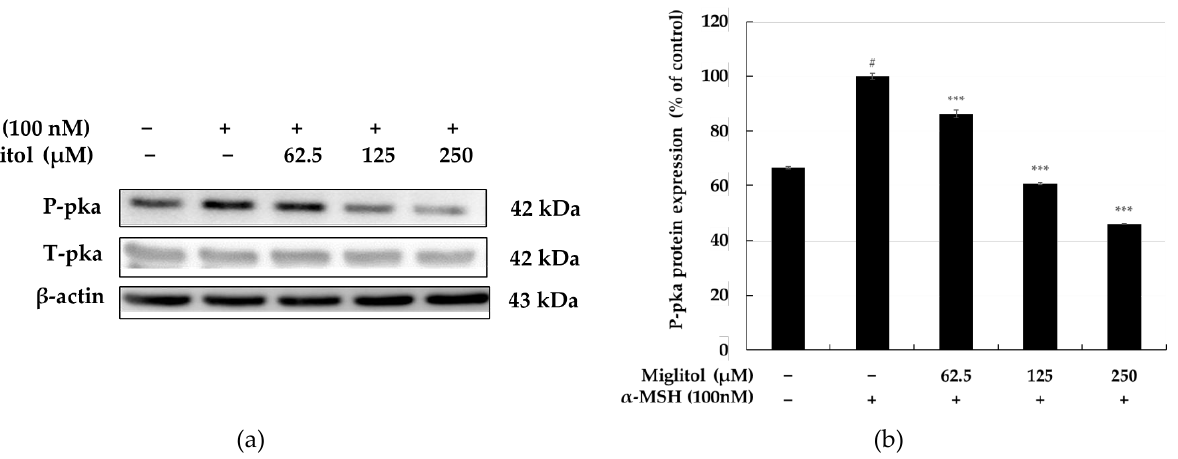
Figure 5. The effect of miglitol on PKA protein expression in α -MSH-stimulated B16F10 cells. Cells were treated with miglitol (62.5, 12 5, and 250 μM) for 24 h in the presence of α -MSH (100 nM). ( a ) Western blotting results, ( b ) P-PKA protein expression. α -MSH was used as the negative control. The results are presented as the mean ± SD from three repeated measurements using ImageJ. # p < 0.001 vs. the unstimulated control group; *** p < 0.001 vs. α -MSH alone.